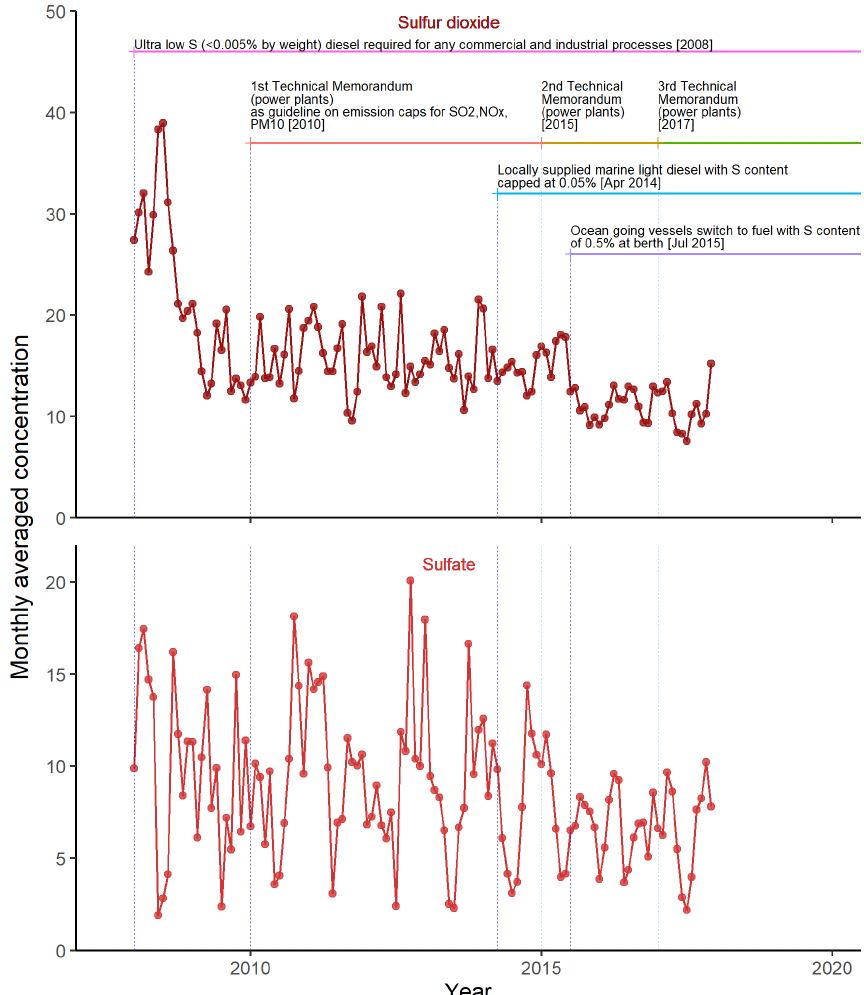
Figure 7. The 10-year variation of monthly SO 2 and sulfate concentration. The significant SO 2 emission control measures implemented in Hong Kong are indicated in the top plot. The unit of concentration is micrograms per cubic meter (µgm − 3